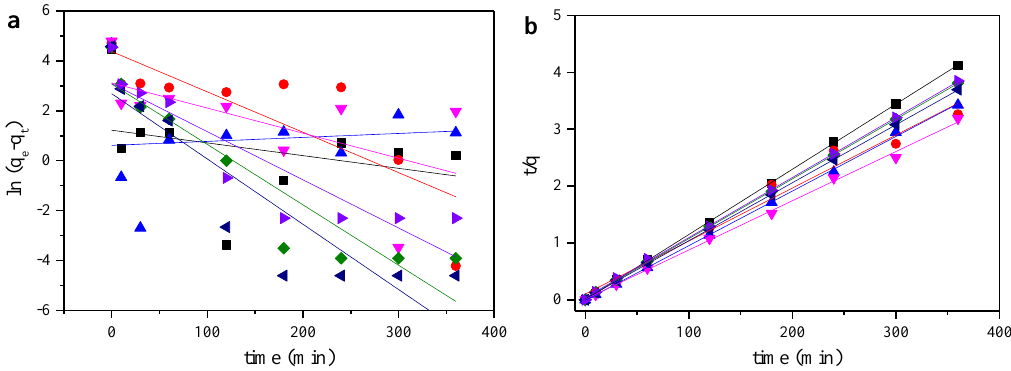
Figure 6. ( a ) fitting of experimental data with quasi-first-order reaction kinetics; ( b ) fitting of experimental data with the quasi-second-order model. The adsorption test was conducted with 2 g / L modified sepiolite and 200 mg / L dye solution for 240 min under oscillation rate of 180 r / min and 25 ◦